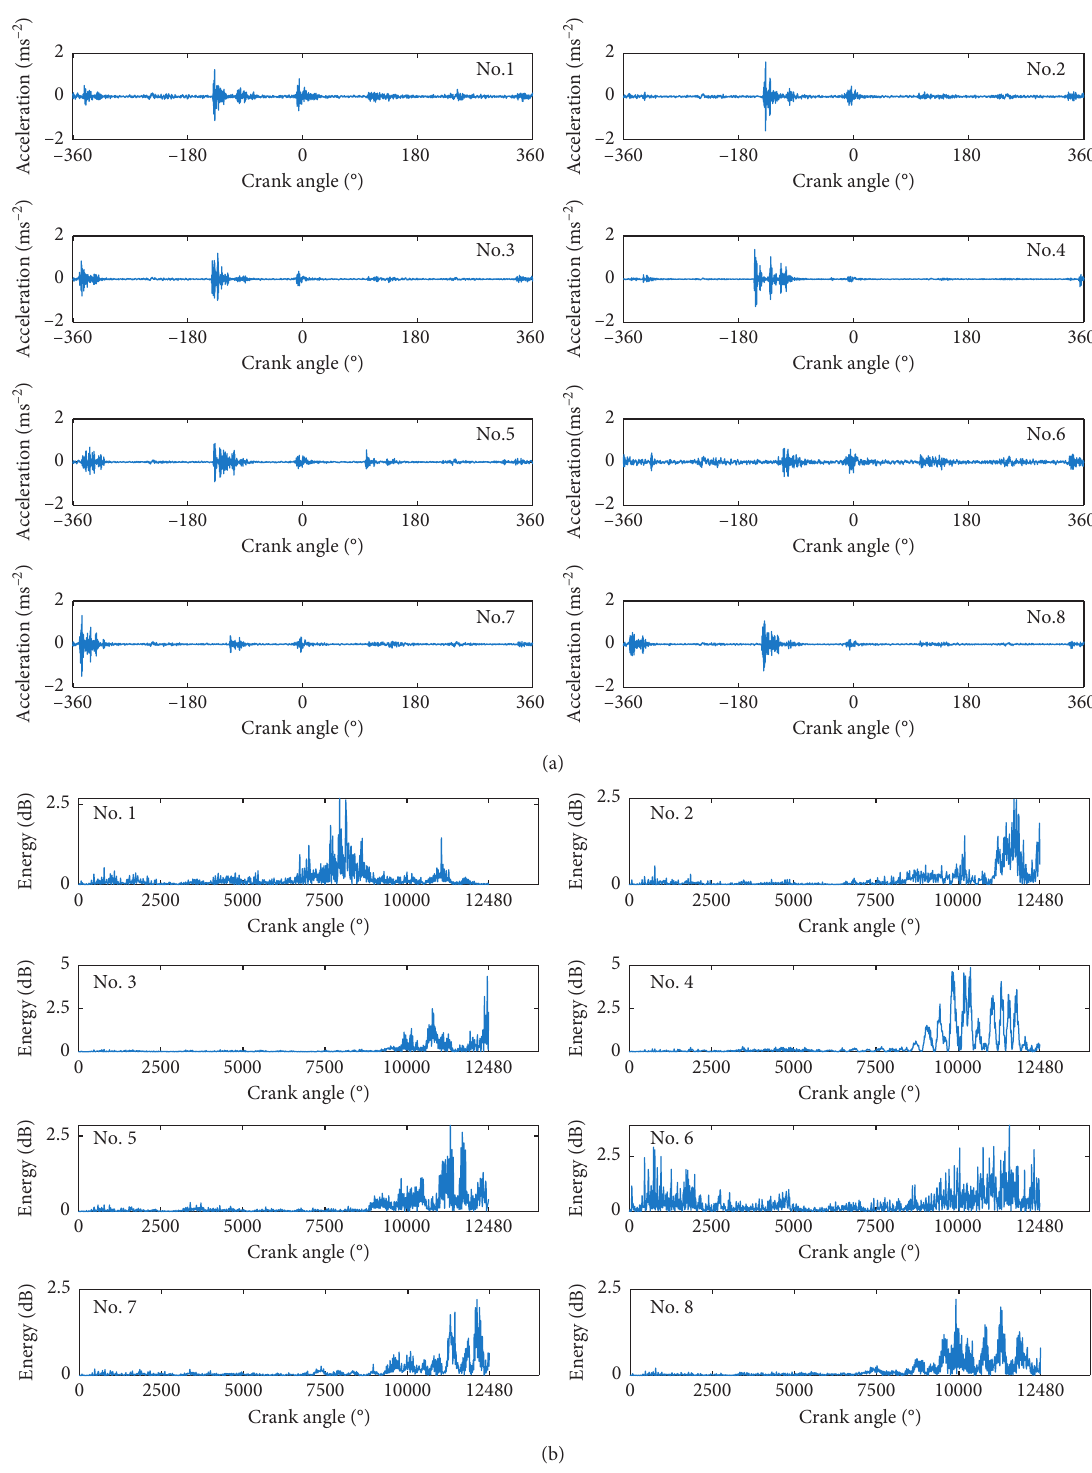
Figure 7: Waveform and power spectrum of signals under 8 conditions. (a) Waveform in time domain. (b) Power faults is easy to confuse; especially, the identification effect indicating that this idea is not feasible. Using the kurtosis corresponding to operating conditions 1, 5, and 8 does not index as a feature for fault identification, the effect is better exceed 70%. Taken together, the effects of the four methods than RMS, and the highest recognition rate can reach more are not very good. than 80%. However, the identification of several types of